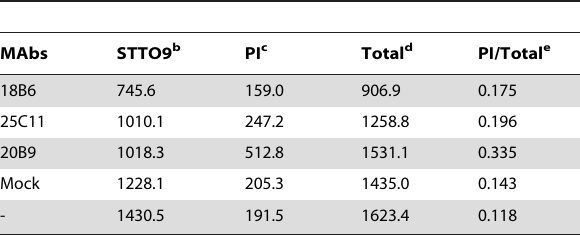
Table 1. Fluorescence quantities of the Live/Dead stained